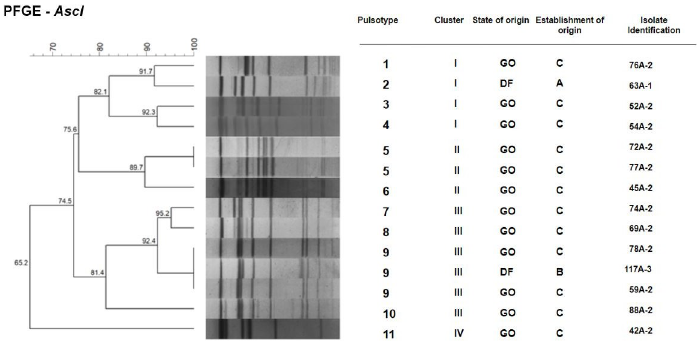
Fig 1. Dendrogram and PFGE patterns of 14 isolates of Listeria monocytogenes restricted with AscI . The data were analyzed using the BioNumerics software. Discrimination of pulsotypes, clusters, origins of isolates (Federal District, DF; or Goia´s, GO), establishment of origin (A, B or C), and isolate identification are presented.